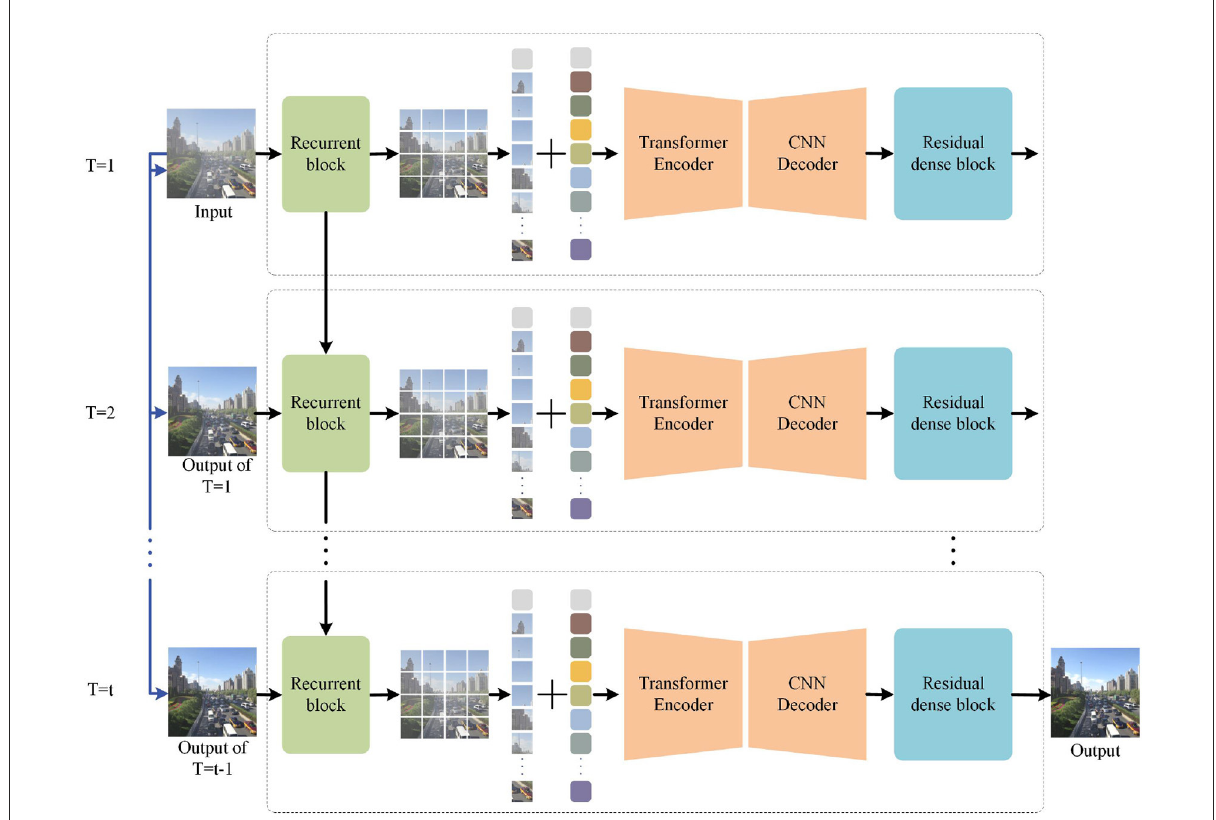
FIGURE2 The proposed framework for PRnet. PRnet extracts early features through recurrent blocks, then extracts multi-scale features through transformer codec, and finally integrates the features into the supervised fusion module. The blue line represents concatenate operation, and the black line represents